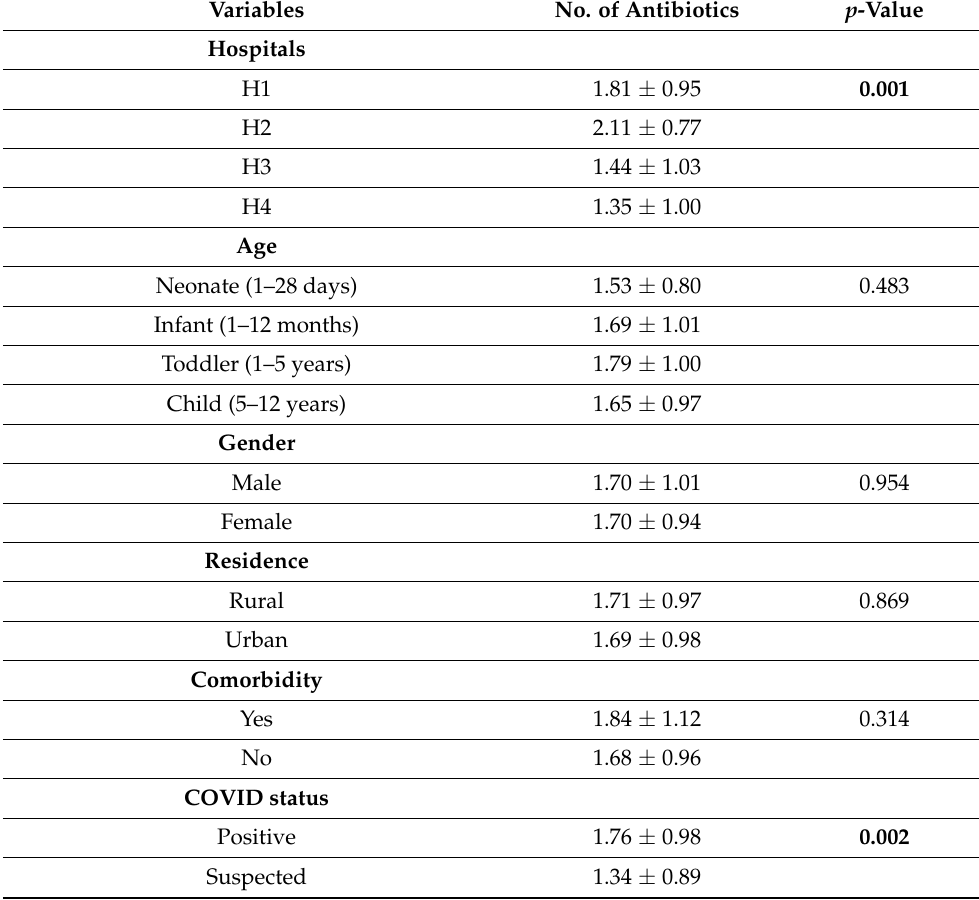
Figure 3. Antibiotic usage classified according to WHO AWaRe Classification. NB: Please refer to the methodology for the definitions of the AWaRe groupings. Table 4. Comparison of antibiotic usage among selected